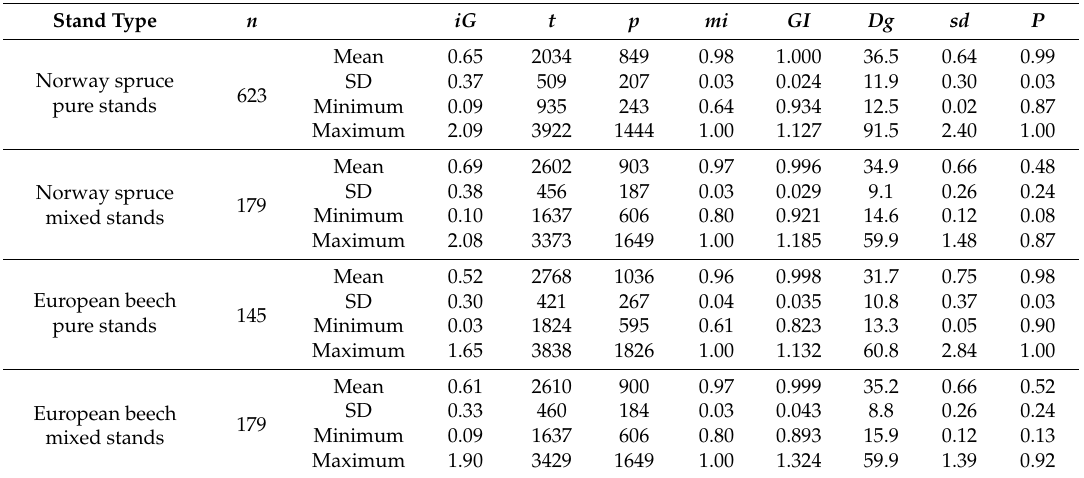
Table 1. Main stand variables of the sample plots used for the growth modelling. Stand Type